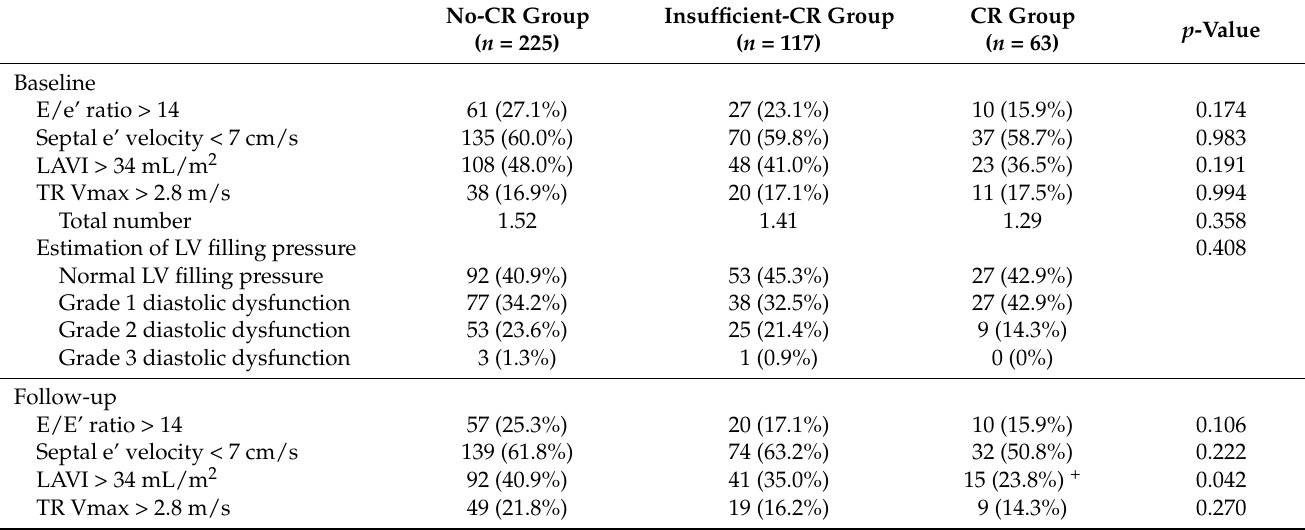
Table 3. Echocardiographic variables of diastolic dysfunction according to the cardiac rehabilitation